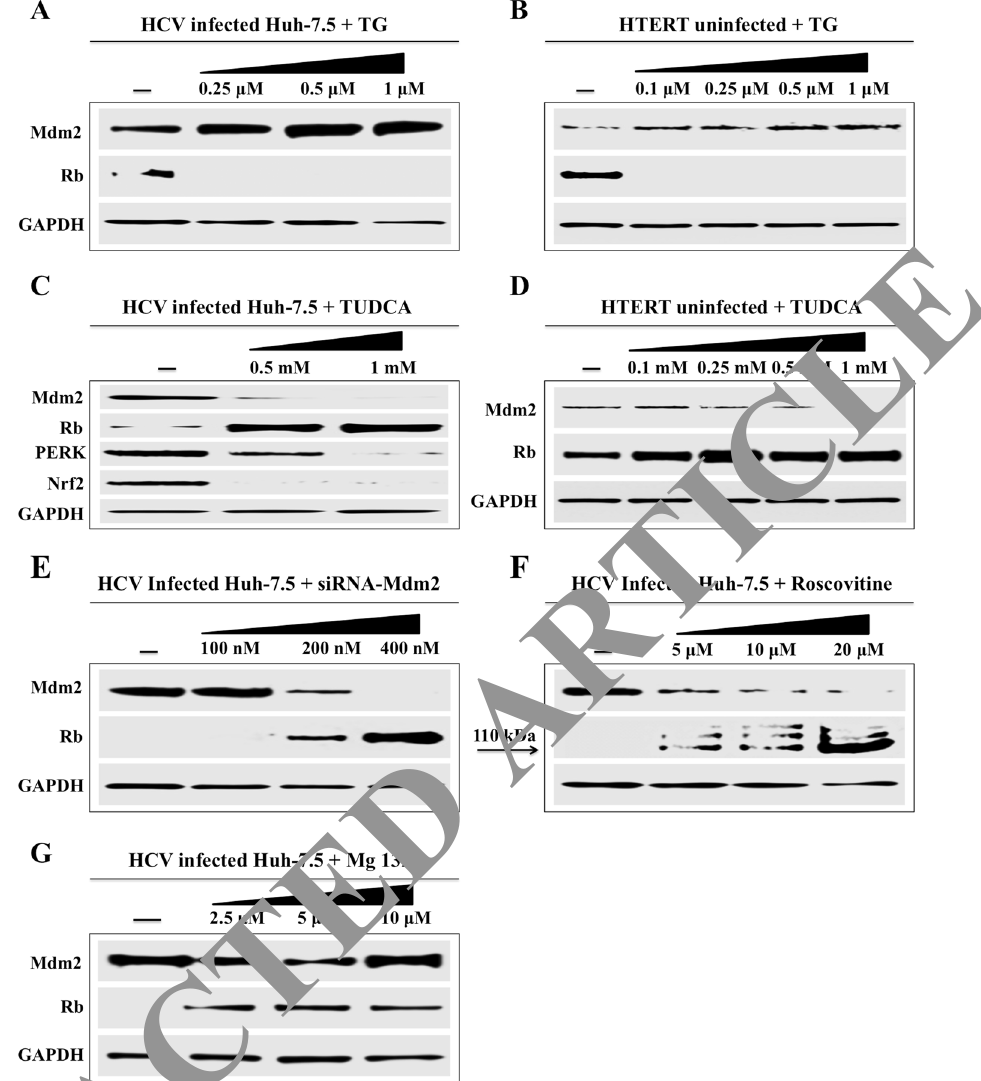
Figure 7. Western blot analysis shows the effect of ER-stress inducer (TG), inhibitor (TUDCA) and siRNA mediated silencing of Mdm2 on the expression of Rb in HCV infected and uninfected hepatic cells. (A) HCV infected Huh-7.5 cells were treated with variable concentrations of TG. After 24 hours, the expression of Mdm2 and Rb expression were examined by Western blot analysis. (B) Similar analysis was performed using an immortalized human hepatocyte cell line (HTERT) after treatment with TG. (C) HCV infected cells were treated with ER-stress inhibitor (TUDCA). The expression of Mdm2 and Rb levels were examined by Western blot. The expressions of PERK and Nrf2 were measured using the same lysate (D) TUDCA treatment of uninfected immortalized human hepatocytes (E) Silencing Mdm2 restores Rb expression. (F) Cyclin dependent kinase (CDK) inhibitor, roscovitine inhibits Mdm2 and restores Rb expression in HCV infected culture. (G) Pre-treatment with proteasome inhibitor (Mg132) restores Mdm2-mediated Rb